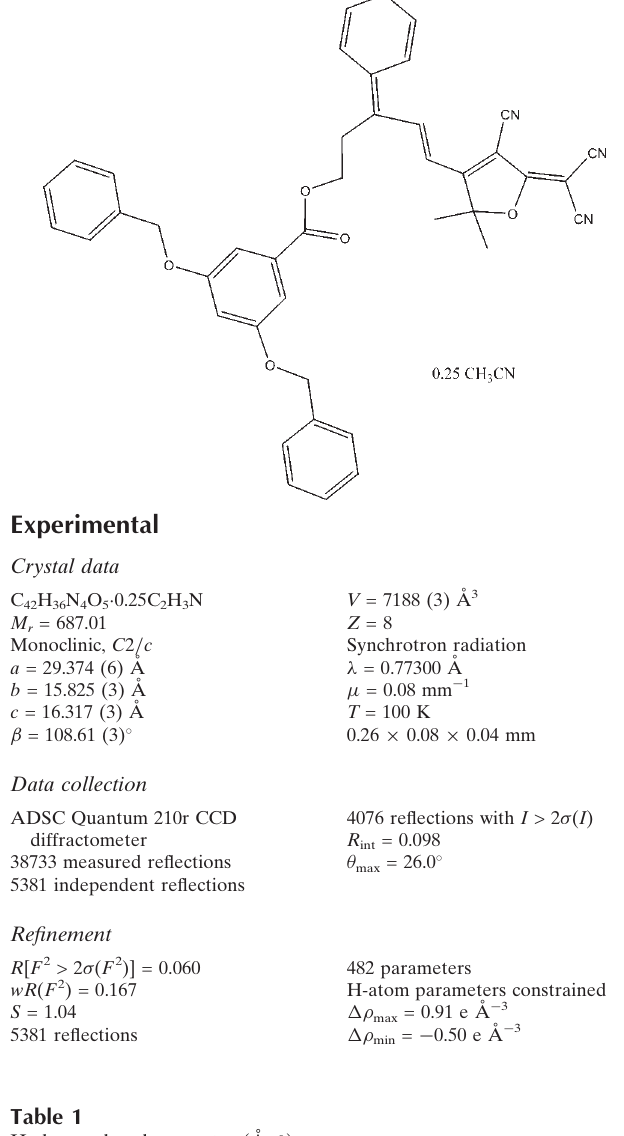
Hydrogen-bond geometry (A˚ , (cid:3)